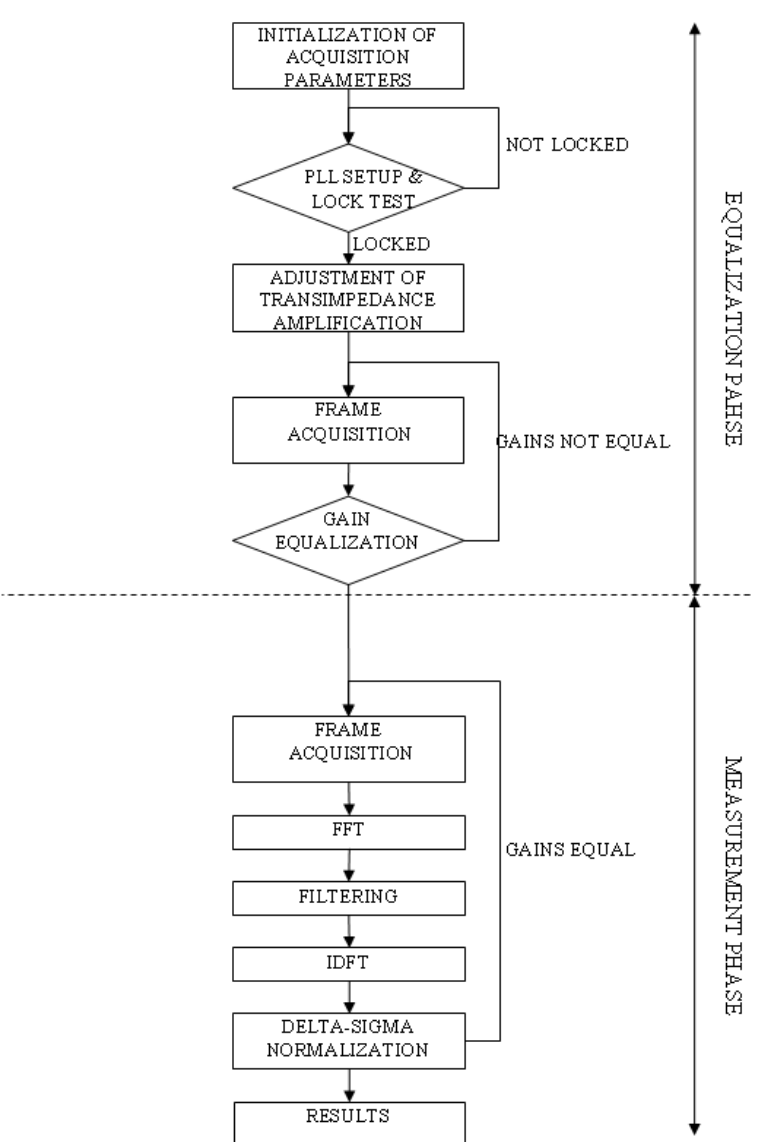
Figure 4. Signal processing